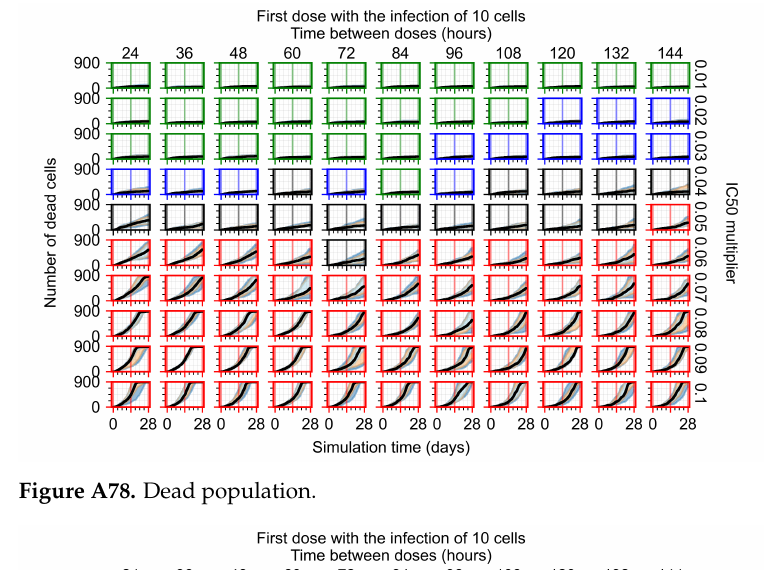
Figure A78. Dead population.